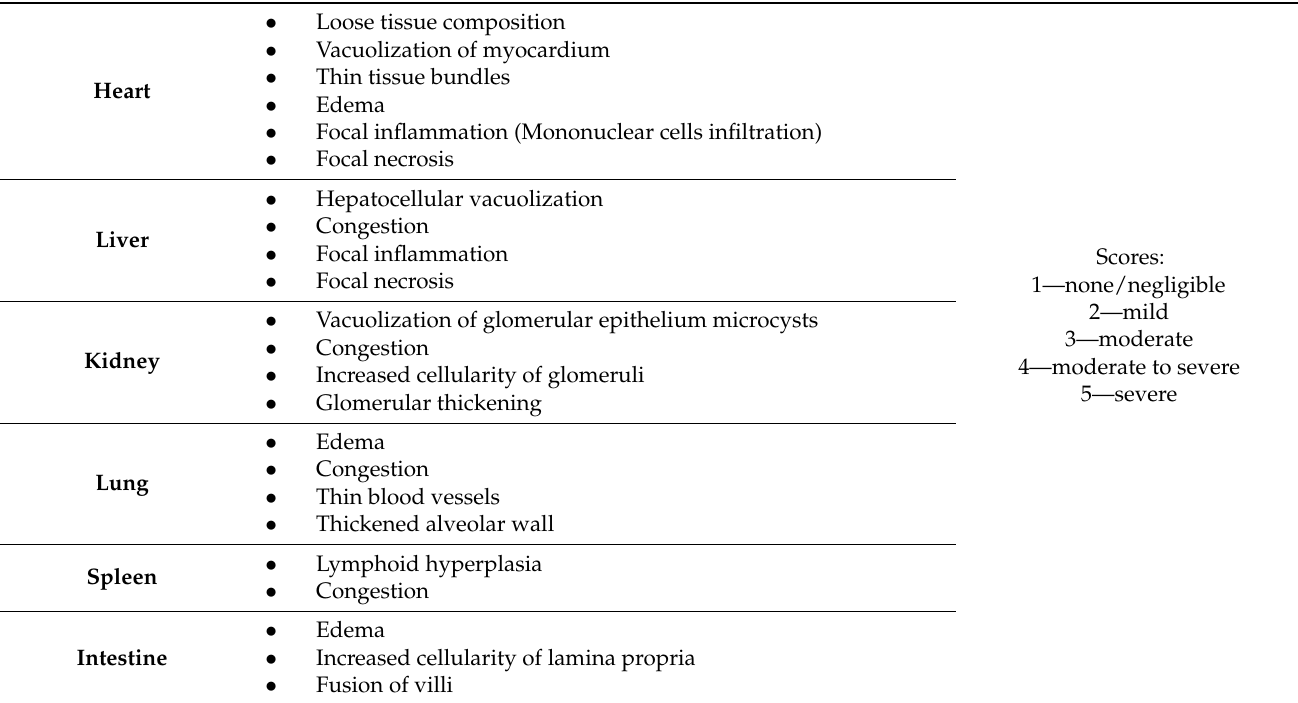
Table 5. Histological tissue features and organ